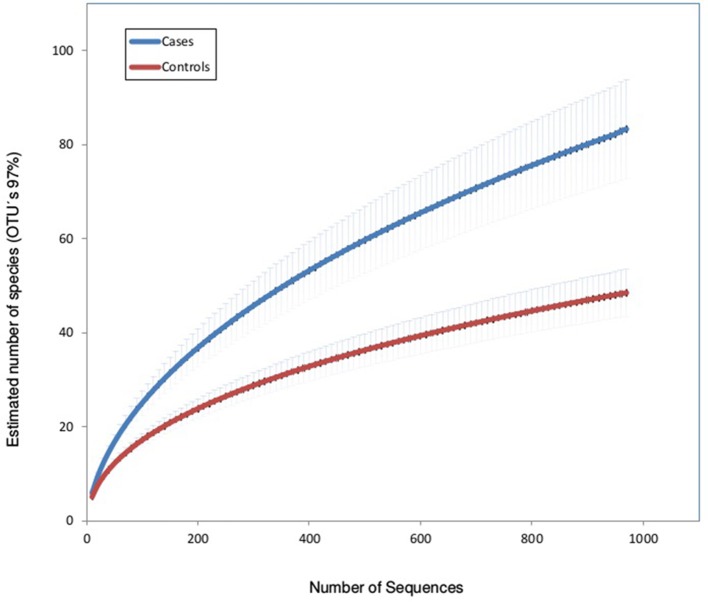
Rarefaction curves of nasopharyngeal samples in patients with invasive pneumococcal disease (cases) and healthy children (controls). The horizontal axis shows the number of reads (sequencing effort) obtained by pyrosequencing the 16S rRNA gene. The vertical axis shows the number (mean ± S.E.) of operational taxonomic units (OTUs) at a level of 97% (estimated mean number of bacterial species).